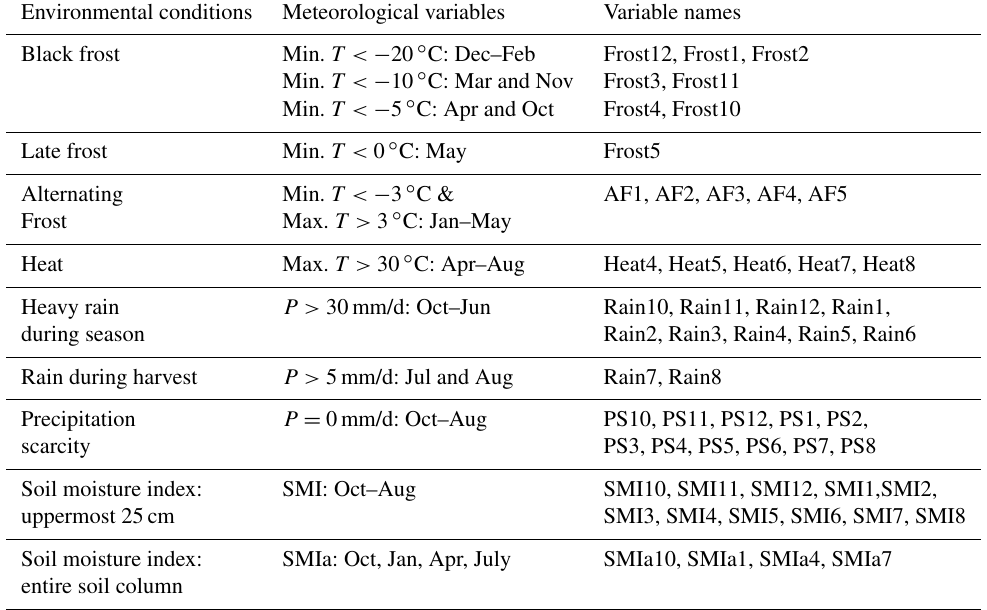
Table 1. Table of the indicators of seven extreme weather conditions as well as an index for soil moisture for different soil depths. Column 2 shows the corresponding meteorological conditions and months of occurrence. The indicators (first column) are generated by counting the days above or below the thresholds of certain meteorological variables for specific months (second column). The variable names of the resulting features are displayed in the last column. The number indicates the month. For example, Frost10 represents the number of days with black frost in October of the previous year and Heat6 the number of days with heat in June. T reflects temperature, P precipitation. SMI denotes the soil moisture index for the uppermost 25cm, SMIa for the entire soil